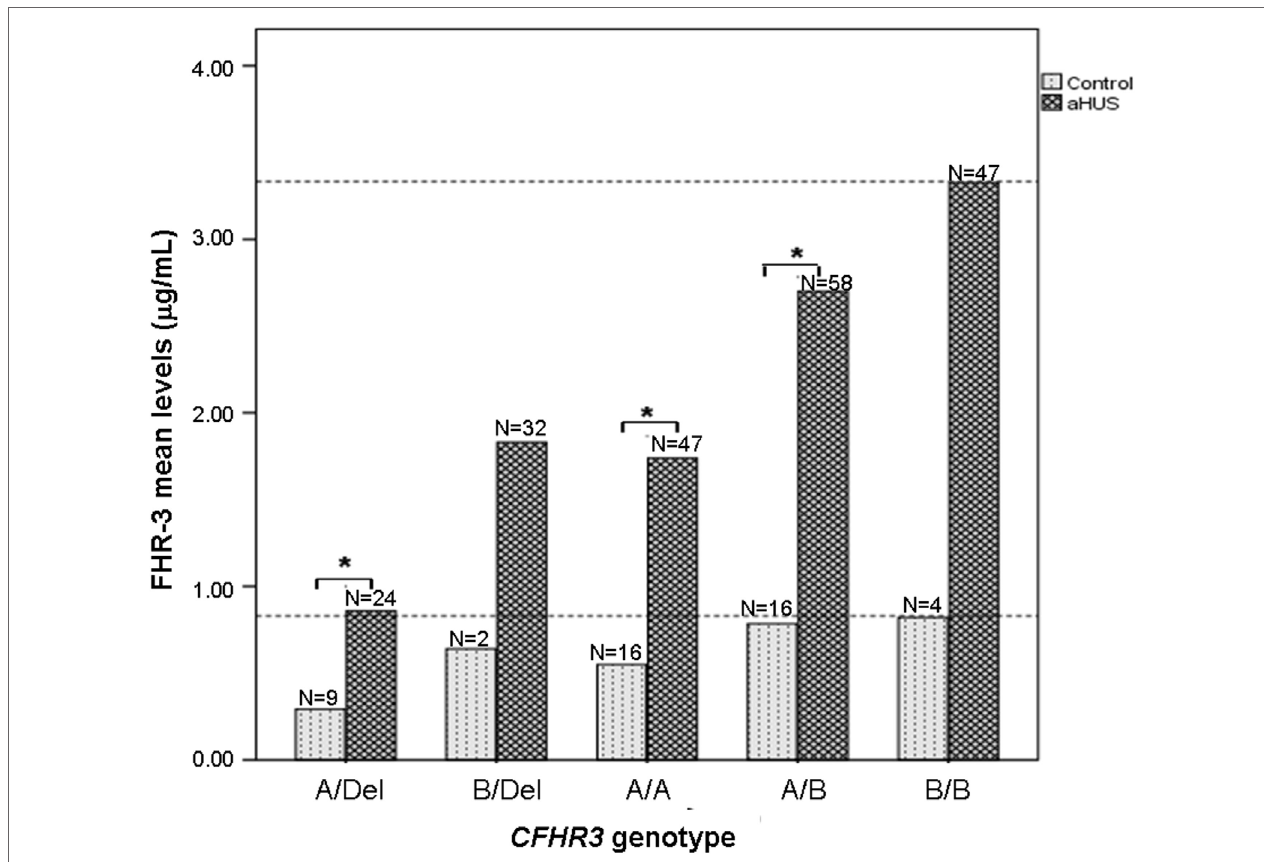
FigUre 3 | FHR-3 levels are higher in patients with atypical hemolytic uremic syndrome (aHUS) than in controls. Histogram showing the mean FHR-3 levels in controls and in patients with aHUS with different CFHR3 genotypes. Statistically significant differences (Kruskal–Wallis test, p < 0.05) are denoted by an asterisk. Dashed lines indicate the highest FHR-3 level observed in controls and